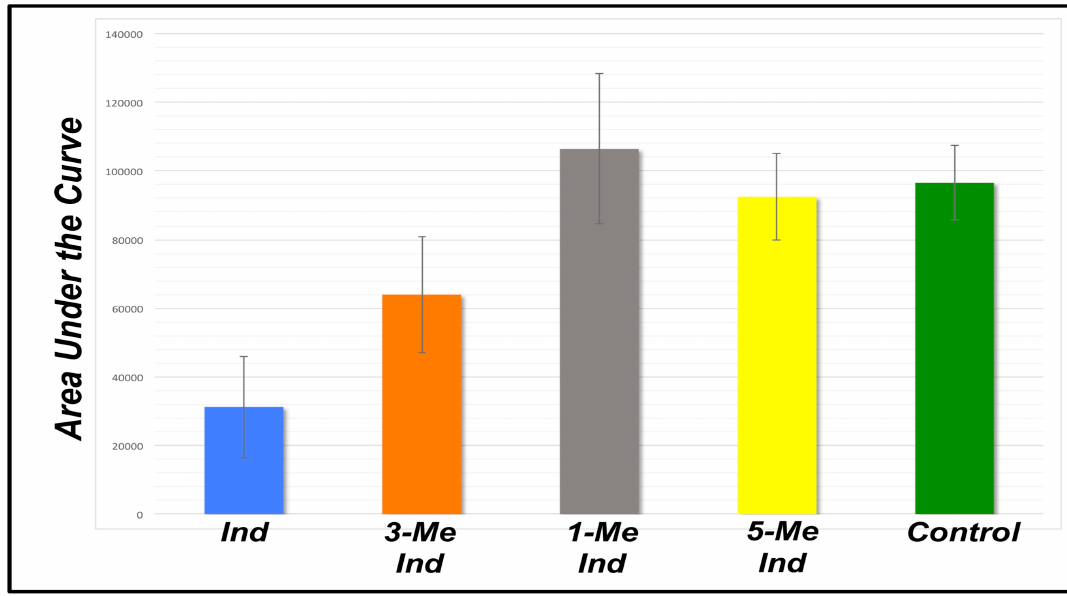
Figure 1. A novel plate-based biosensor to detect indole with high sensitivity. The Attenu fluorescence-quenching assay was adapted to develop a biosensor and rAgamOBP1 at 1 µ M served as the detector element. The fluorescent dye, 1-NPN, binds rAgamOBP1 and results in a signal that can be detected spectrophotometrically. Analytes capable of binding to rAgamOBP1 displace the dye from the protein’s binding pocket, thus resulting in fluorescence quenching. The tested compounds at 10 µ M concentration included indole (Ind), 3-methyl indole (3-Me Ind), 1-methyl indole (1-Me Ind), and 5-methyl indole (5-Me Ind). Six replicates of each compound were evaluated. Three replicates were performed with rAgamOBP1 and bu ff er alone as controls. The loss of signal indicates a binding event; thus, note the signal drop generated by indole and to a lesser degree 3-methyl indole. The bars are STDEV determined with Excel and the raw data are shown in Appendix A Table